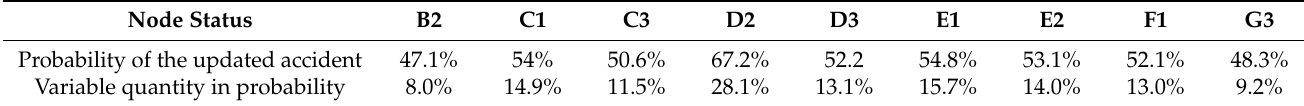
Table 5. Single node status affecting the probabilities of